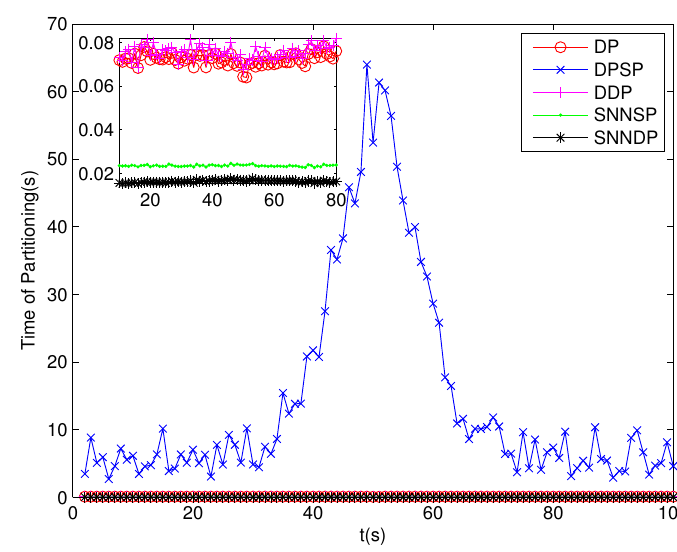
Figure 15. Computational time of the ET-GMPHD filter.